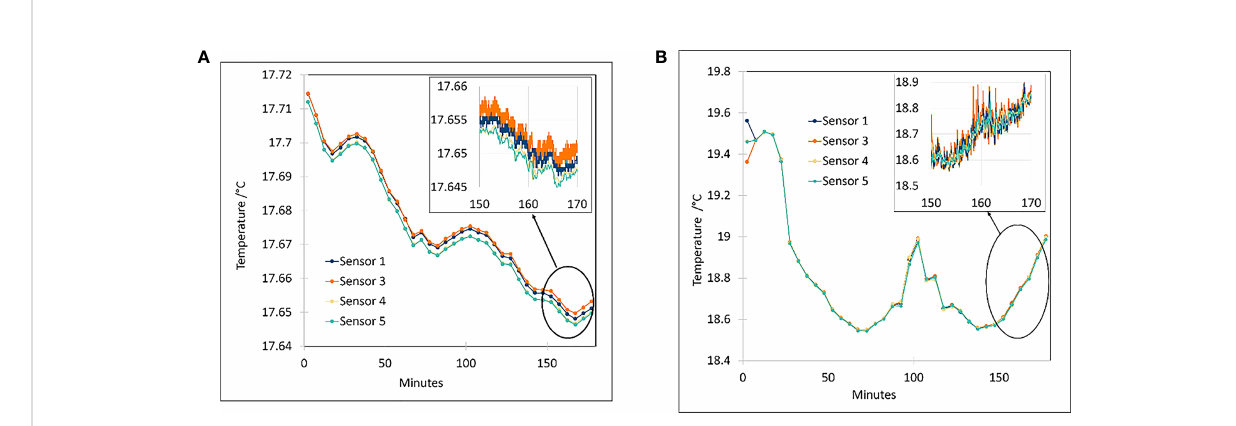
fi gure on the left-hand side, collected on 23/24 September 2020 between 22:40 and 01:40 (corresponding to time period